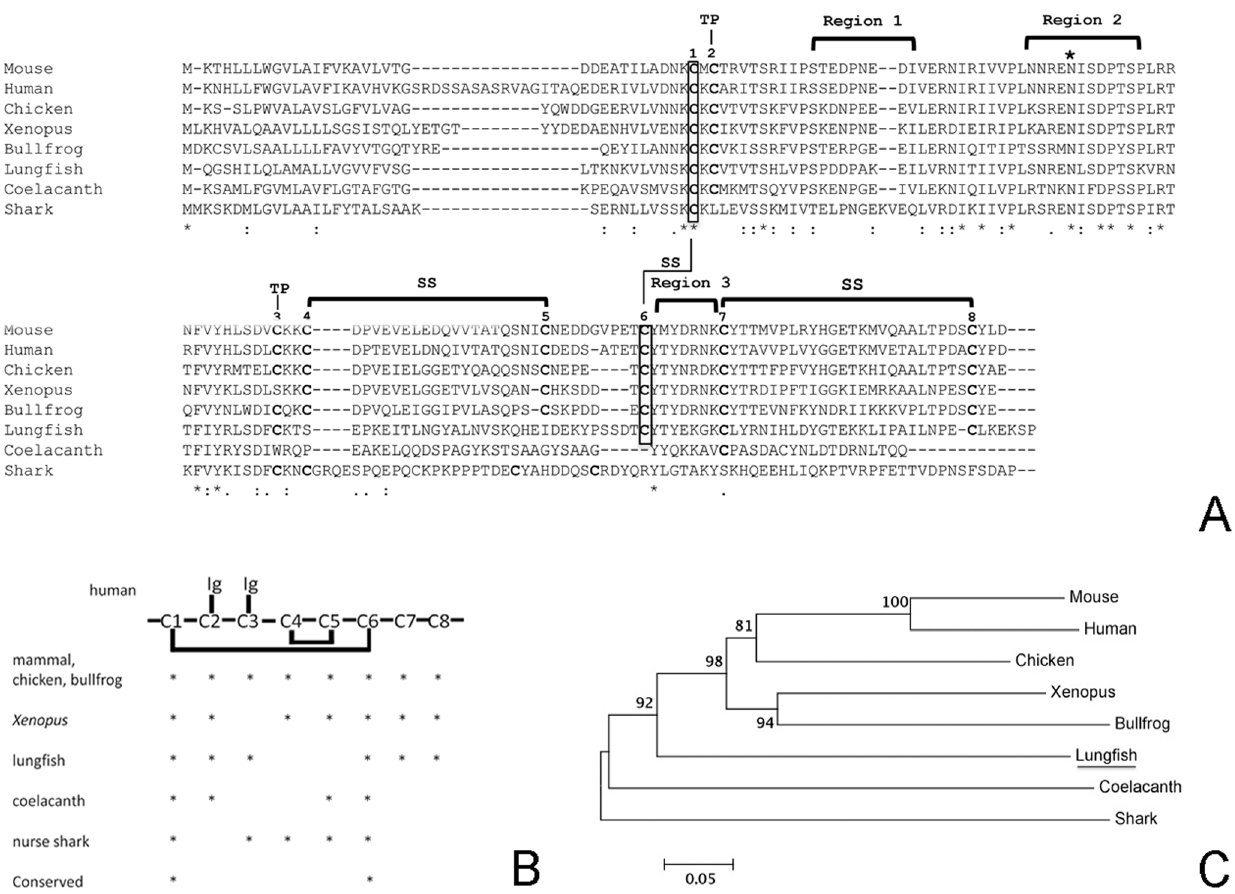
Figure 2. Lungfish J chain molecular analysis. A) Alignment of the J chain amino acid sequences of lungfish (JX999962), mouse (AAH06026), human (ABI63362), chicken (BAB83927), Xenopus (AAC05636), bullfrog (ACO52584), coelacanth (ENSLACP00000023629) and shark (AAO24897). ‘‘SS’’ indicates the interchain disulfide bridges and ‘‘TP’’ marks the Cys paired with the secretory tail of IgA or IgM. The conserved N-linked glycosilation site is indicated by ‘‘ + ’’. Numbers (1–8) indicate the Cys residues in human sequences. ‘‘*’’ Indicates identical amino acids between all sequences, whilst ‘‘.’’ and ‘‘:’’ show conservative substitutions. Regions 1–3 were identified as in Braathen et al (2007) B) Conservation of Cys residues between lungfish and other vertebrates. C) Phylogenetic tree showing the evolutionary relationship of J chain molecules in vertebrates. The tree was constructed using the Neighbour-Joining method in MEGA 4 and was bootstrapped 10,000 times. GenBank accession numbers are as follows: lungfish (JX999962), mouse (AAH06026), human (ABI63362), chicken (BAB83927), Xenopus (AAC05636), bullfrog (ACO52584), coelacanth (ENSLACP00000023629) and shark (AAO24897).